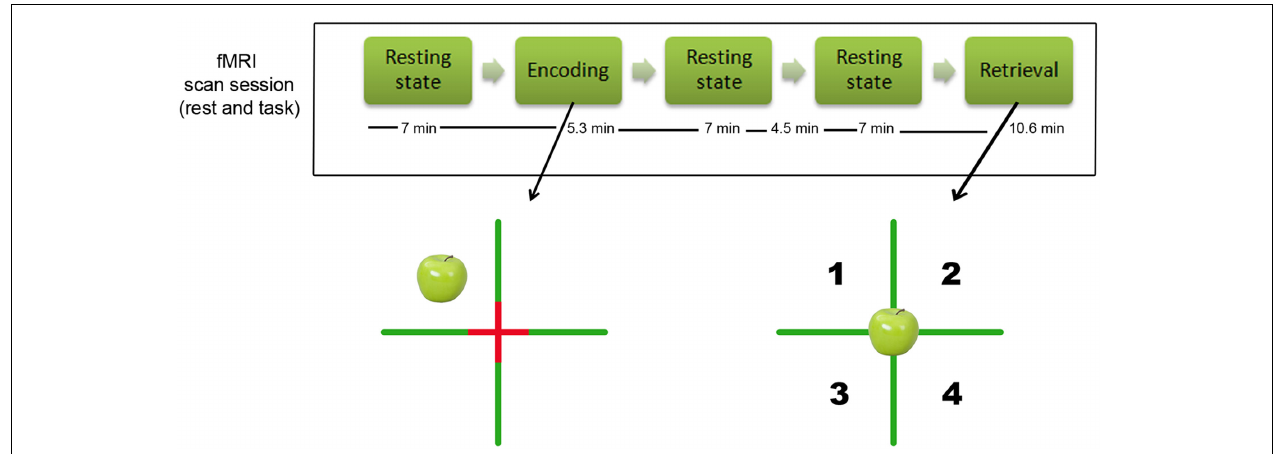
FIGURE 1 | Design of the study. Top of the figure: illustration of the design of the study and timing of the resting-state MR resting state scans. The time indications reflect the duration of each sequence in minutes (note that there was 4.5min pause between the two resting-state scans after encoding). Bottom of the figure: illustration of